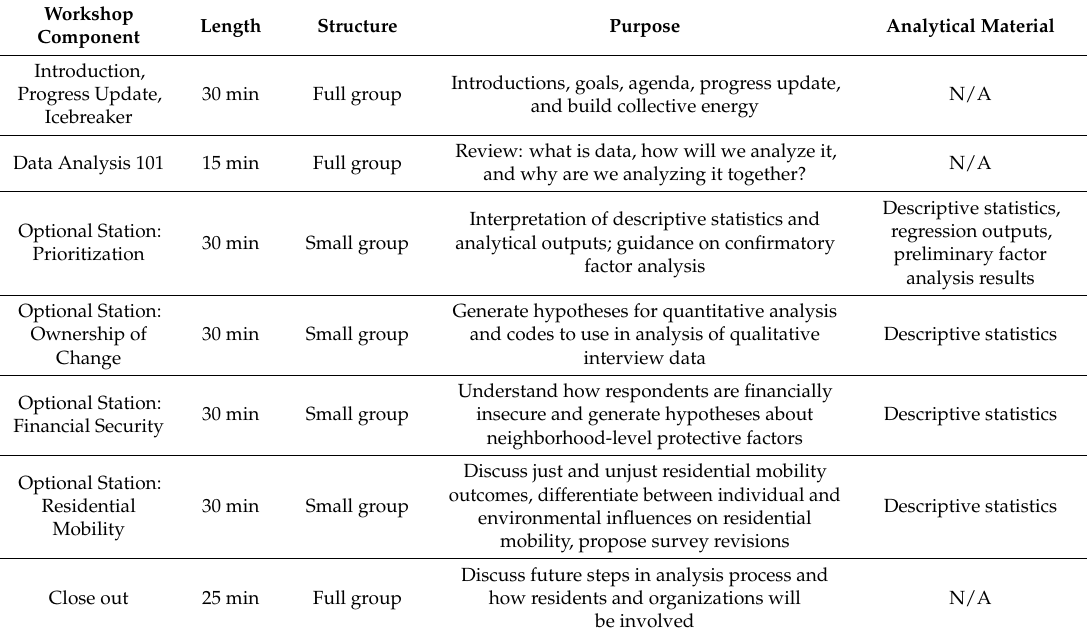
Table 4. Collaborative data analysis workshops,